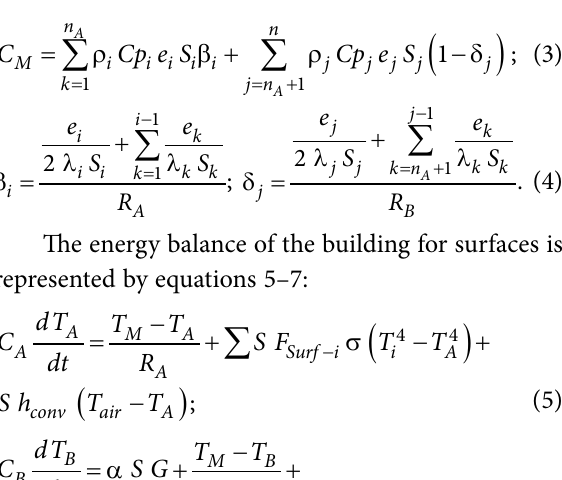
Fig. 1. Wall spatial discretisation and conduction